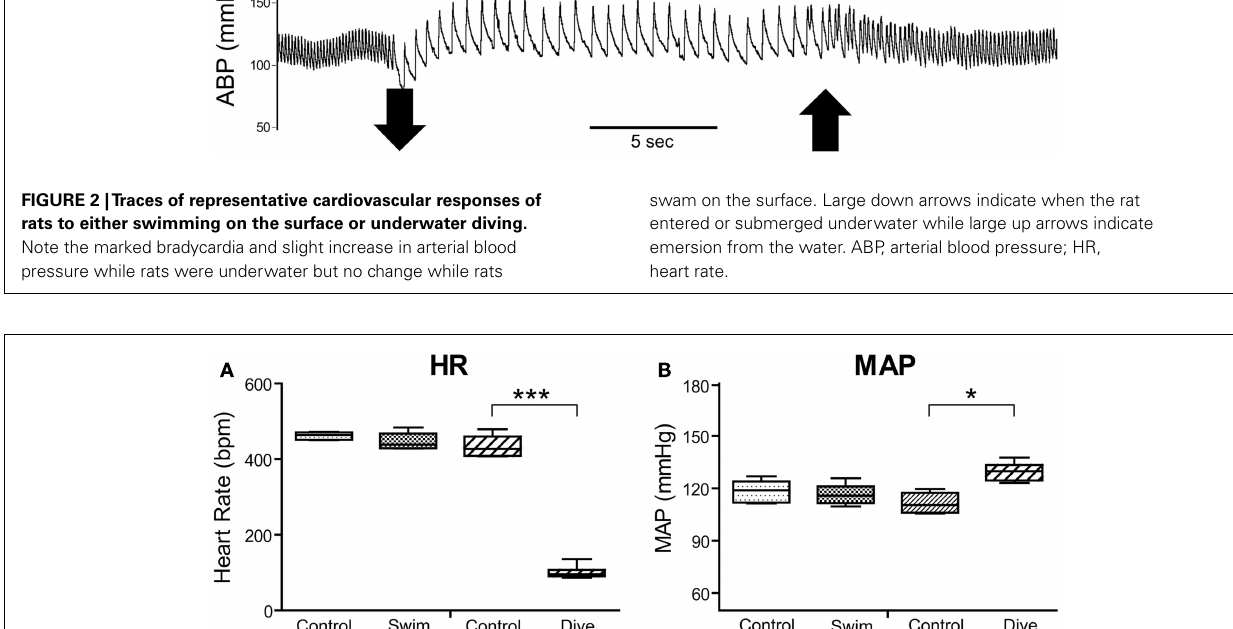
FIGURE 3 | Box plots illustrating changes in heart rate (A) and MAP (B) in rats to either swimming or underwater diving. Note that only diving behavior induced significant bradycardia and increases in mean arterial blood pressure. *** p < 0.001; * p <